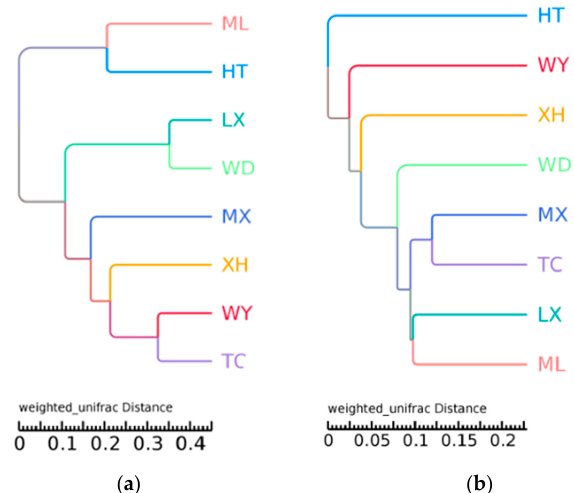
Figure 4. UPGMA tree of different fungal ( a ) and bacterial ( b ) community structures at the phylum level in the different samples.